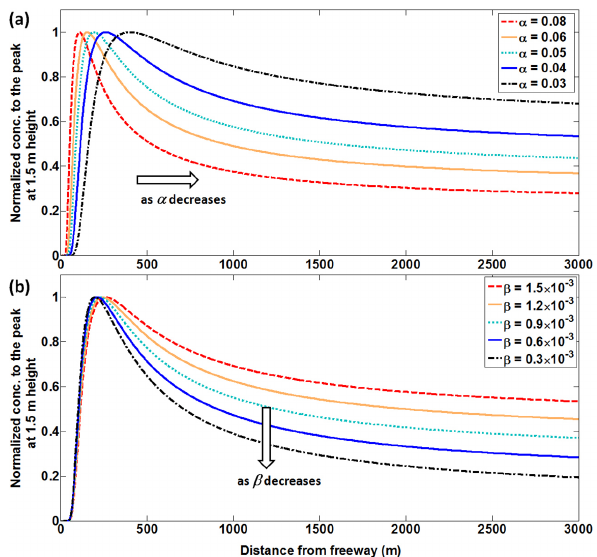
Figure 1. Variations in spatial profiles of pollutants calculated with Eqs. (2) and (3) varying α or β . The x axis is distance downwind from freeway and y axis is normalized concentrations to the peak at 1.5m height ( z = 1.5m). Results were obtained (a) with fixed Q c and β = 1.5 × 10 − 3 and varying α from 0.03 to 0.08, and (b) with a fixed Q c and α = 0.04, changing β from 0.3 to 1.5 × 10 − 3 .